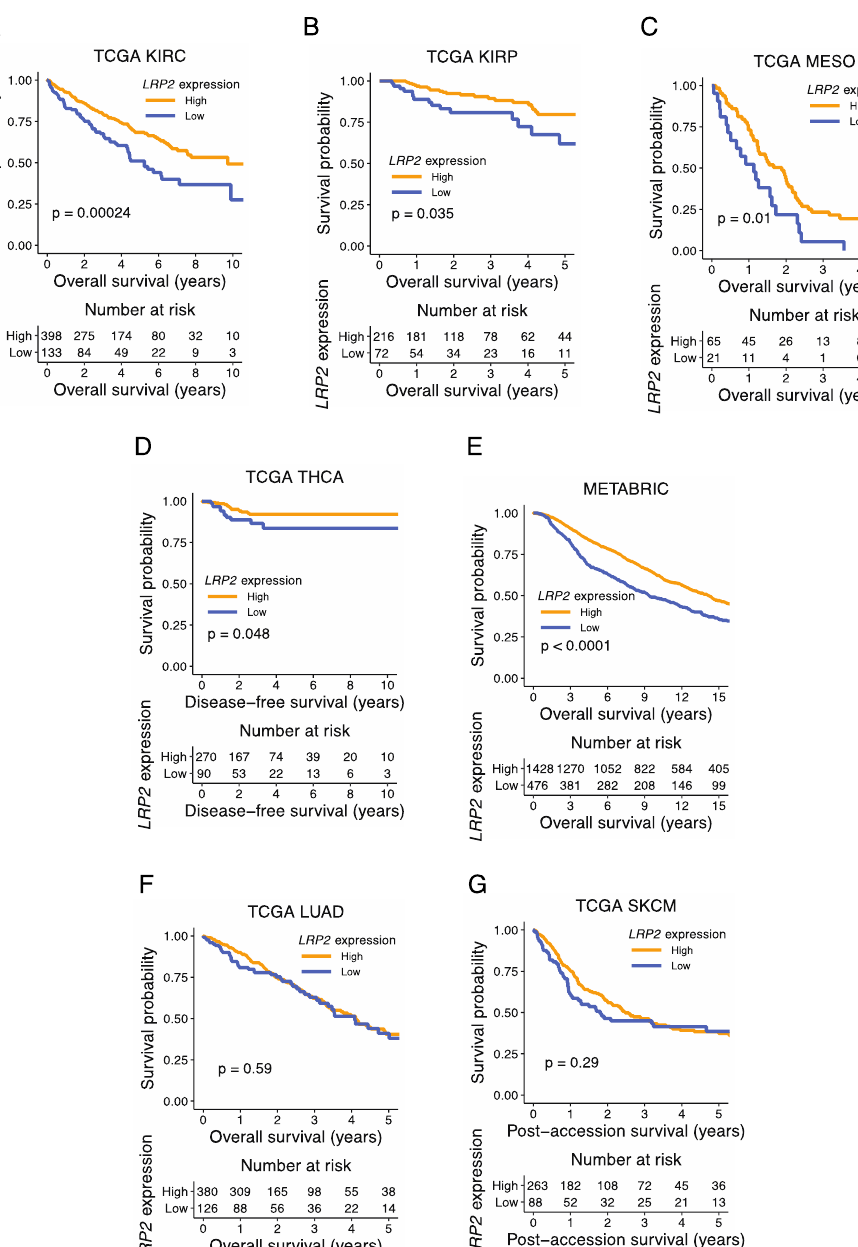
Figure 5. Low LRP2 expression is associated with poor outcome in multiple cancers. ( A – G ) Kaplan–Meier curve of LRP2 high and LRP2 low groups stratified based on the lower quartile of LRP2 expression in each dataset (upper panel) and risk table (lower panel). p value from the log-rank test is shown.